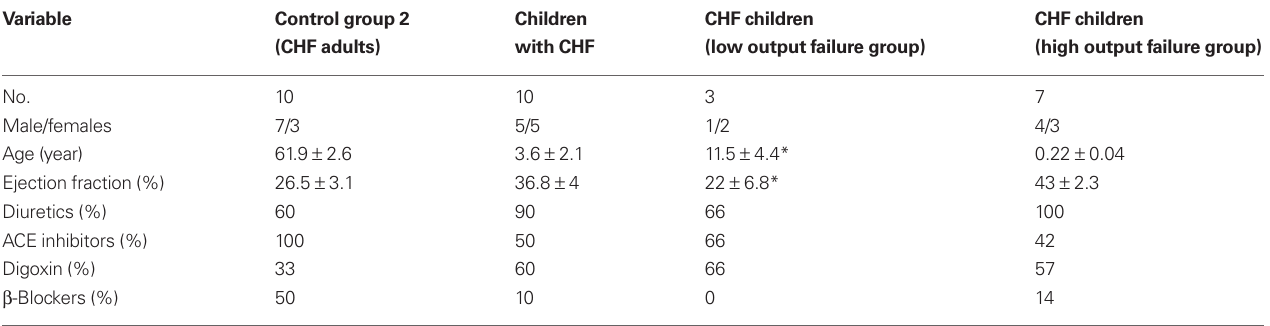
Data presented as mean ± SEM. *p < 0.05 (from other two groups).